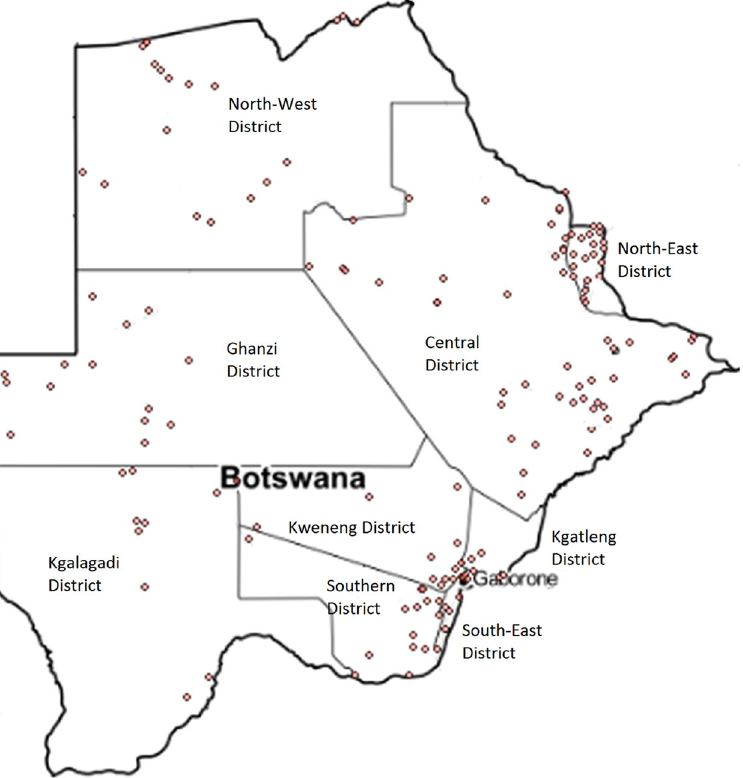
Figure 1. Botswana Administrative Districts and sampling locations made with R 3.2.4 79 (http://www.R- project.org) package ggplot2 (https://cran.r-project.org/web/packages/ggmap/citation.html) 80 and